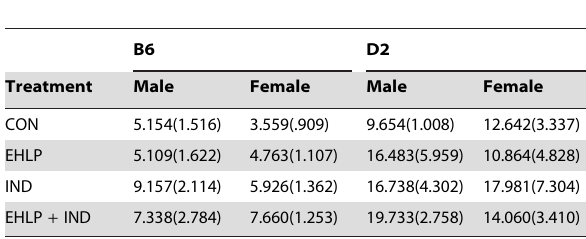
Table 2. Means and standard errors for latency to enter an open quadrant (s).